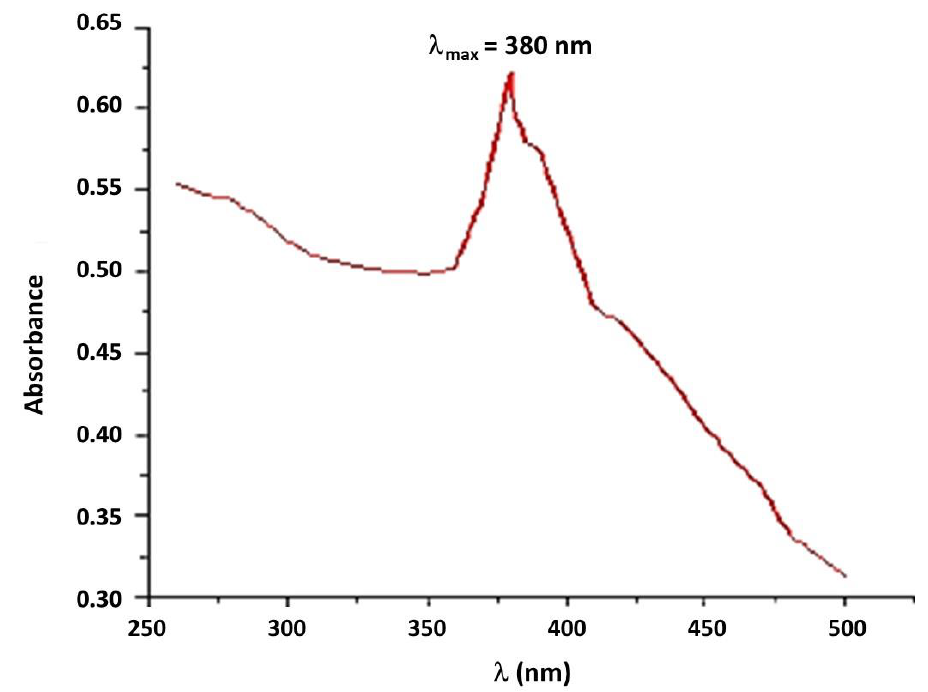
Figure 2. UV-visible spectrum of TPE-mediated ZnO NPs. Table 2. FTIR assignments of functional groups observed in TPE-mediated ZnO